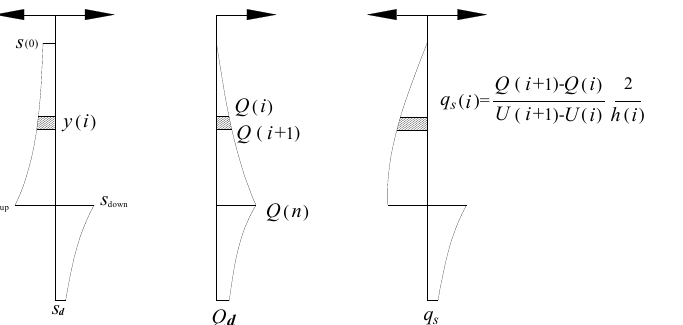
Figure 4. Relationship between axial force, side friction resistance, and displacement by accurate conversion method.